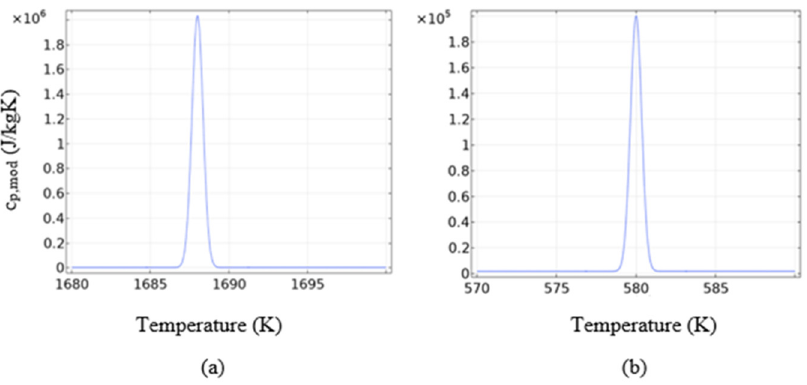
Figure 2. Modified specific heat. ( a ) Silicon and ( b ) NaNO 3. (Source: Yadav and Samir, 2019